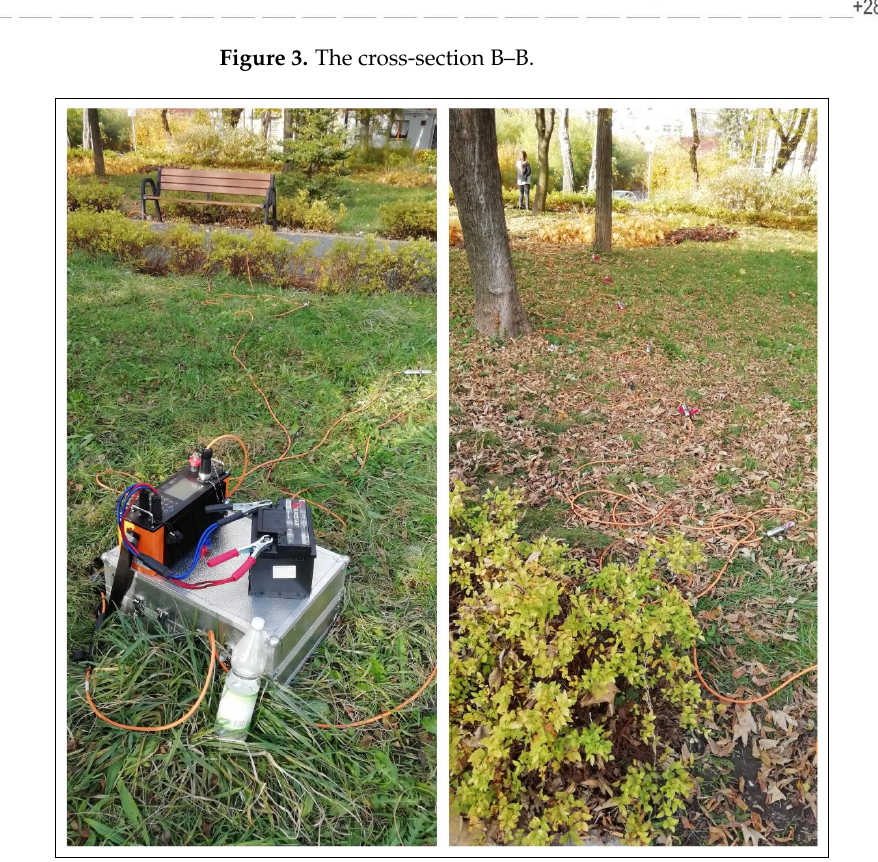
Figure 4. The general look over the area of